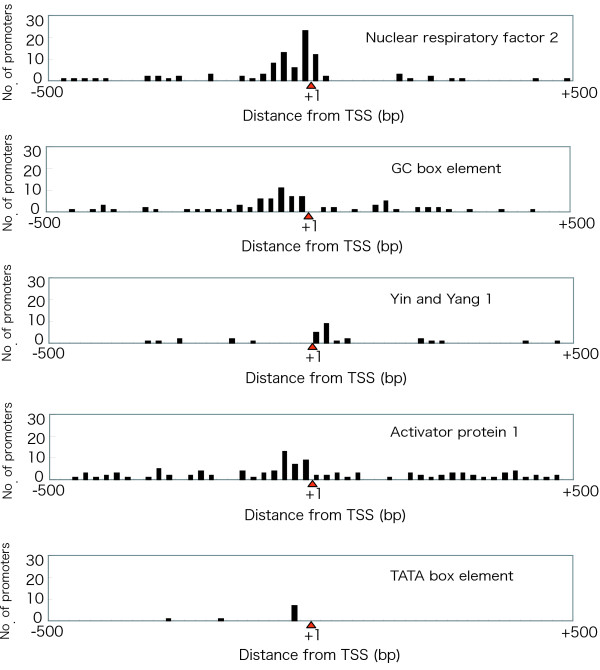
Distribution of predicted transcription factor binding sites. The distance from the TSS (bp) is shown on the X axis, and the number of predicted transcription factor binding sites is shown on the Y axis. The red triangle depicts TSS (+1).